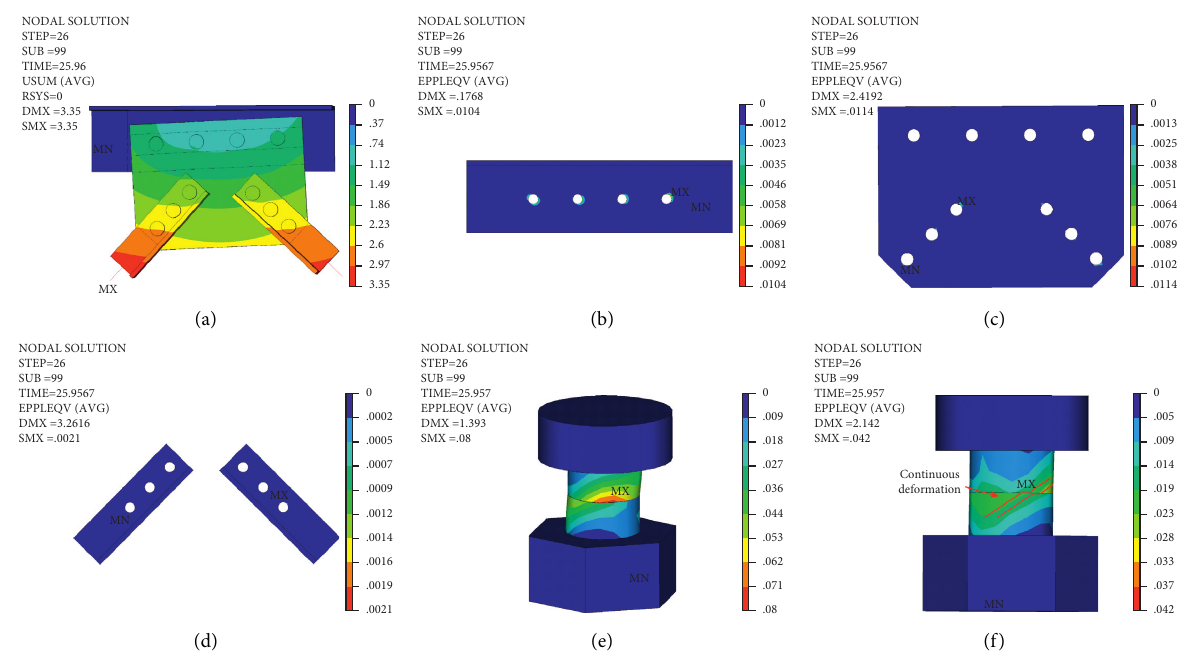
Figure 8: Simulation results for Case 6. (a) Displacement of joint. (b) Plastic strain of main angle steel. (c) Plastic strain of gusset plate. (d) Plastic strain of branch angle steel. (e) Plastic strain of bolts on main angle steel. (f) Plastic strain of bolts on branch angle